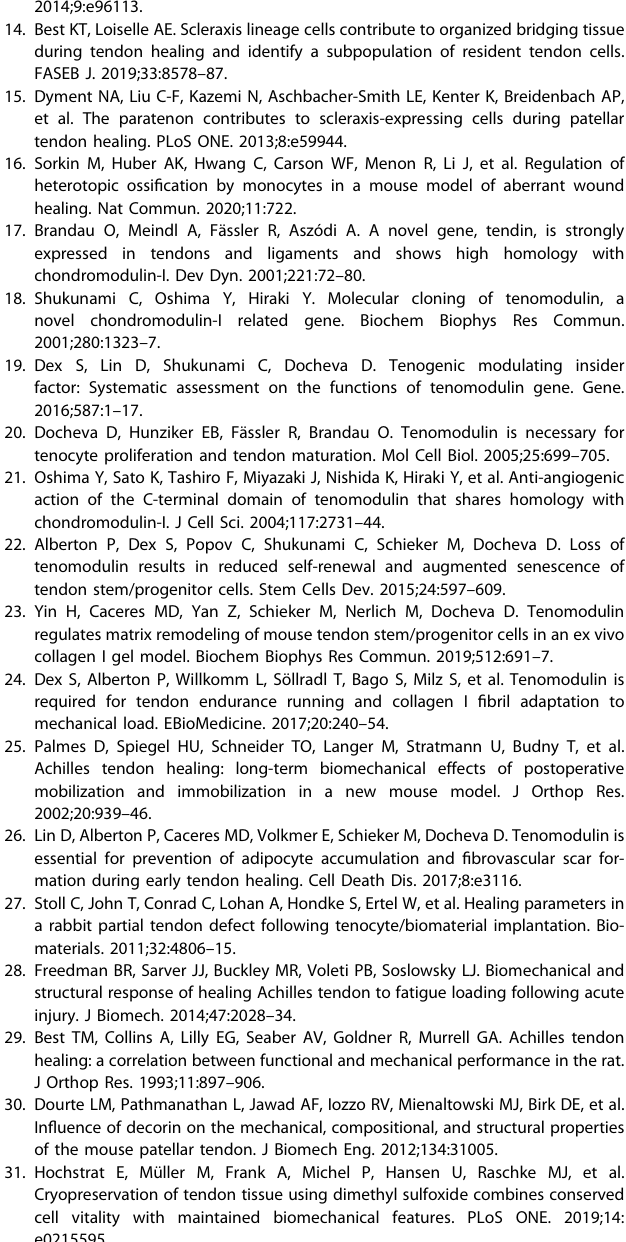
Fig. 6 Single cell RNA-sequencing of Tnmd − / − ScxGFP + and WT ScxGFP + cells isolated from non-injured Achilles tendons. A Volcano plot shows – Log 10 FDR i.e. adjusted p-value and Log 2 Fc expression values of all genes, each dot represents a gene. Signi fi cantly differentially expressed genes (DEGs) ( – Log 10 FDR < 0.05 and |Log 2 Fc | > 1) are highlighted in color other than gray. Vertical lines present the Log 2 Fc threshold equaling 1 or − 1; genes outside these lines are DEGs with at least 2-Fc. The horizontal lines show – Log 10 FDR corresponding to FDR thresholds of 0.05, 0.001 and 0.0001 from the bottom respectively. Red, purple and blue dots represent the signi fi cant DEGs with 2-Fc and – Log – Log fi cant nor have expression above 2-Fc. – Log 10 FDR < 0.0001, 10 FDR < 0.001 and 10 FDR < 0.05 respectively. Gray dots are neither signi B Heat map depicting the Log 2 CPM expression value of selected top 100 signi fi cant DEGs. Top 100 genes with lowest q-value are depicted. Genes are colored according to their Log 2 CPM expression values. Clustering on the top is based on cell type and degradation level. C – E GO enrichment analysis of the signi fi cantly DEGs; results are depicted in dot plot format where top 10 enriched ontology terms are listed on y -axis and the percentage of hits (number of DEGs/number of background genes associated to each term) are indicated on x-axis. Dots size represents the count of DEGs associated with each term, whilst the color shows the enrichment p -value. Top enriched terms from C Biological Process, D Molecular Function and E Cellular Component. F KEGG signaling pathway analysis of the signi fi cant DEGs in dot plot format; y -axis shows top 15 enriched pathways; x-axis indicates gene ratio (number of DEGs/number of background genes associated to each term). Dots size is based on the number of DEGs that were associated with each term, whilst the color shows the p -value of